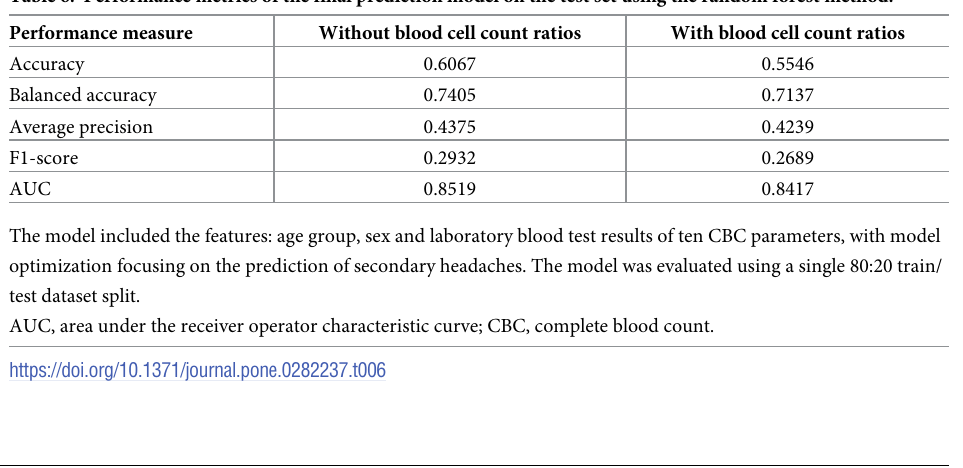
Table 6. Performance metrics of the final prediction model on the test set using the random forest method.